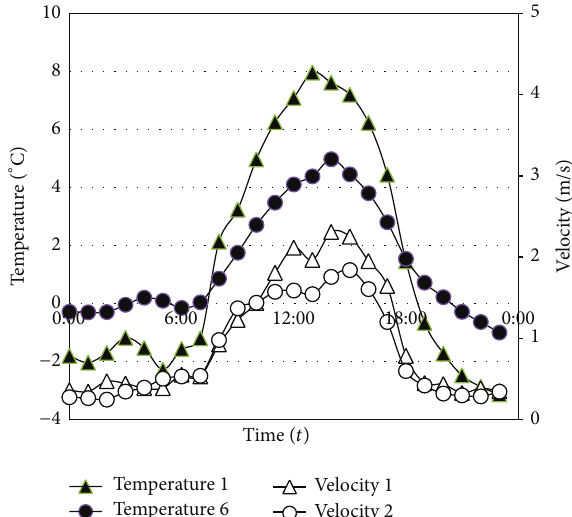
Figure 12: Temperature and wind velocity distribution at measured points by time zone during measurement period.